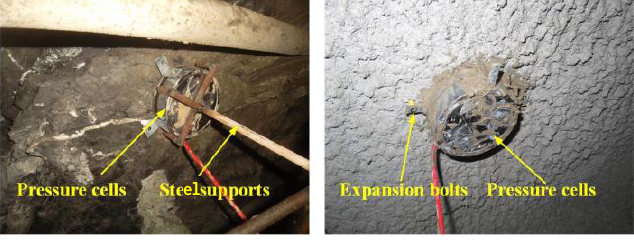
Figure 7. Layout of the earth pressure cells.